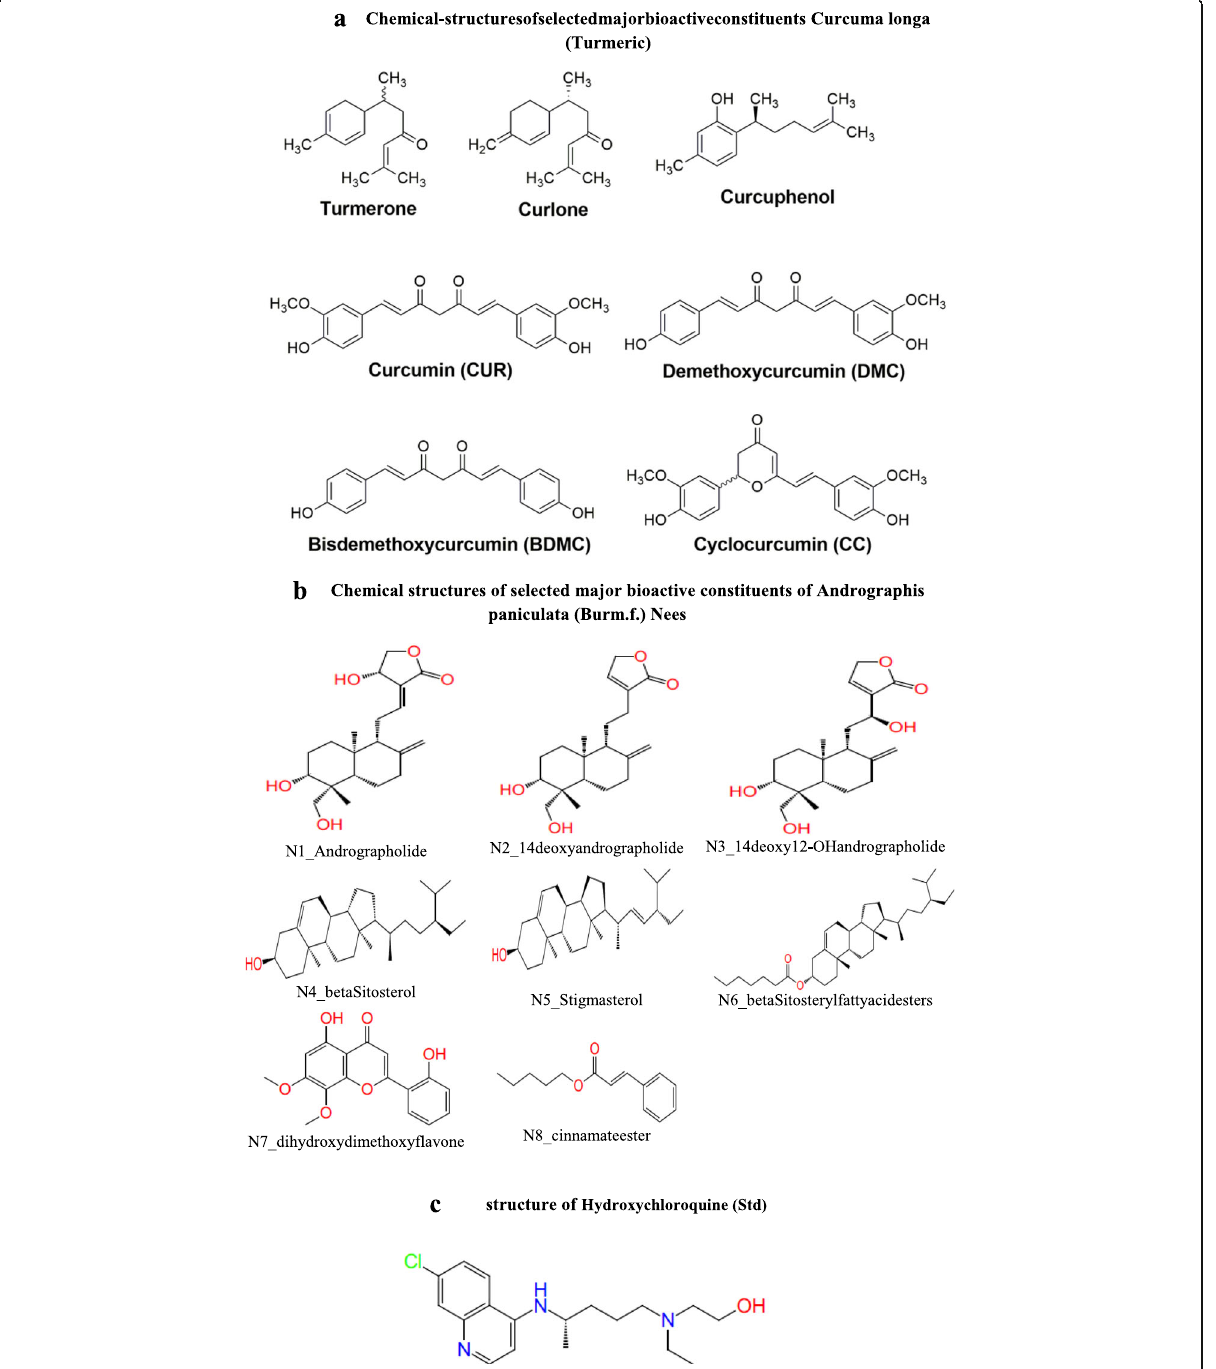
Fig. 1 Structures of phytochemical constituents. a Chemical structures of selected major bioactive constituents of Curcuma longa (turmeric). b Chemical structures of selected major bioactive constituents of Andrographis paniculata (Burm.f.) Nees. c Structure of hydroxychloroquine